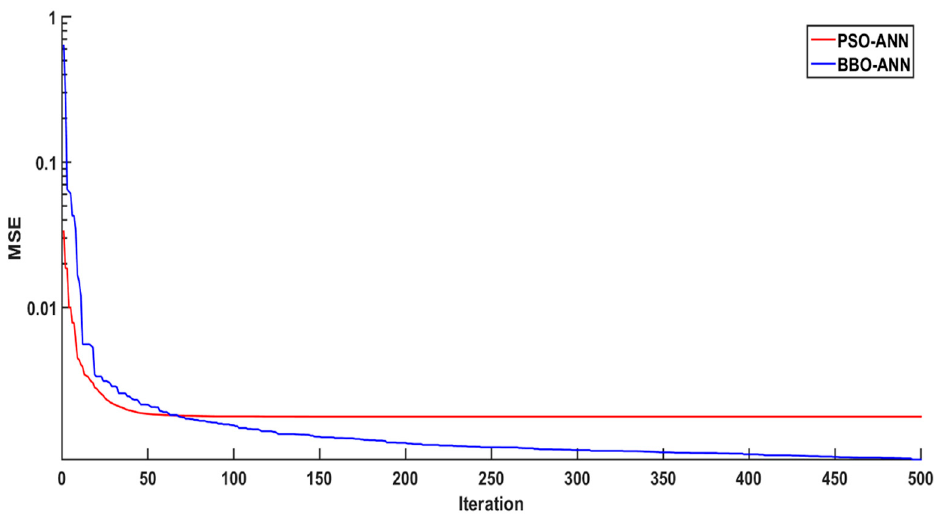
Figure 8. Convergence curve for PSO-ANN and BBO-ANN.